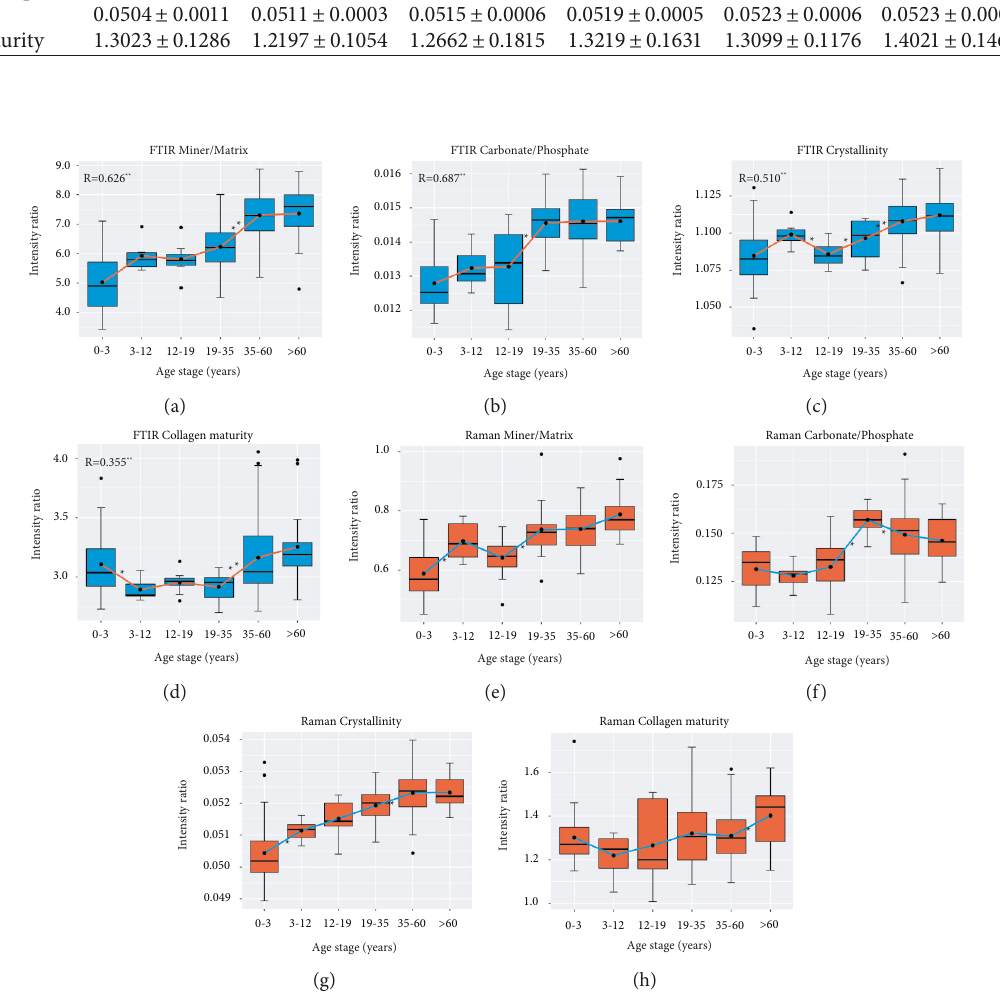
Figure 2: Four outcomes at 6 age stages were evaluated by FTIR and Raman and displayed by box and mean line plots. (a) FTIR mineral/ matrix ratio (900–1200cm − 1 /1592–1712cm − 1 ). (b) FTIR carbonate/phosphate ratio (850–890 cm − 1 /900–1200cm − 1 ). (c) FTIR crystallinity (1030cm − 1 /1020cm − 1 ). (d) FTIR collagen maturity (1660cm − 1 /1690 cm − 1 ). (e) Raman mineral/matrix ratio (410–460cm − 1 / 1215–1300cm − 1 ). (f) Raman carbonate/phosphate ratio (1050–1100cm − 1 /930–980cm − 1 ). (g) Raman crystallinity (1/FWHM PO 43 − ] 1 ). (h) Raman collagen maturity (1660cm − 1 /1690cm − 1 ). Significant differences are indicated, test). Pearson correlation coefficients R between the techniques are indicated in